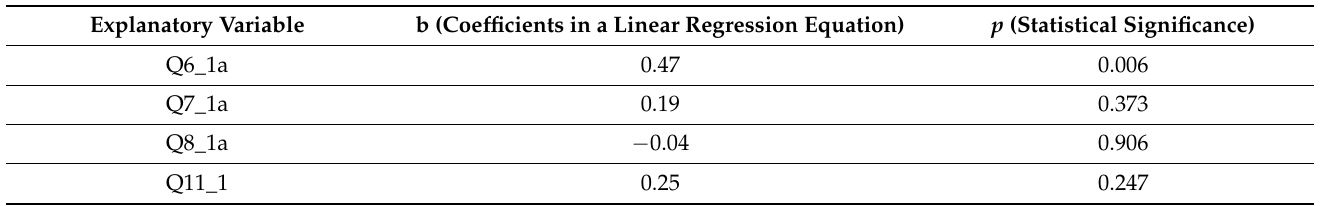
Table 6. Multiple linear regression coefficients for Q28a vs. Q6_1a, Q7_1a, Q8_1a, and Q11_1.